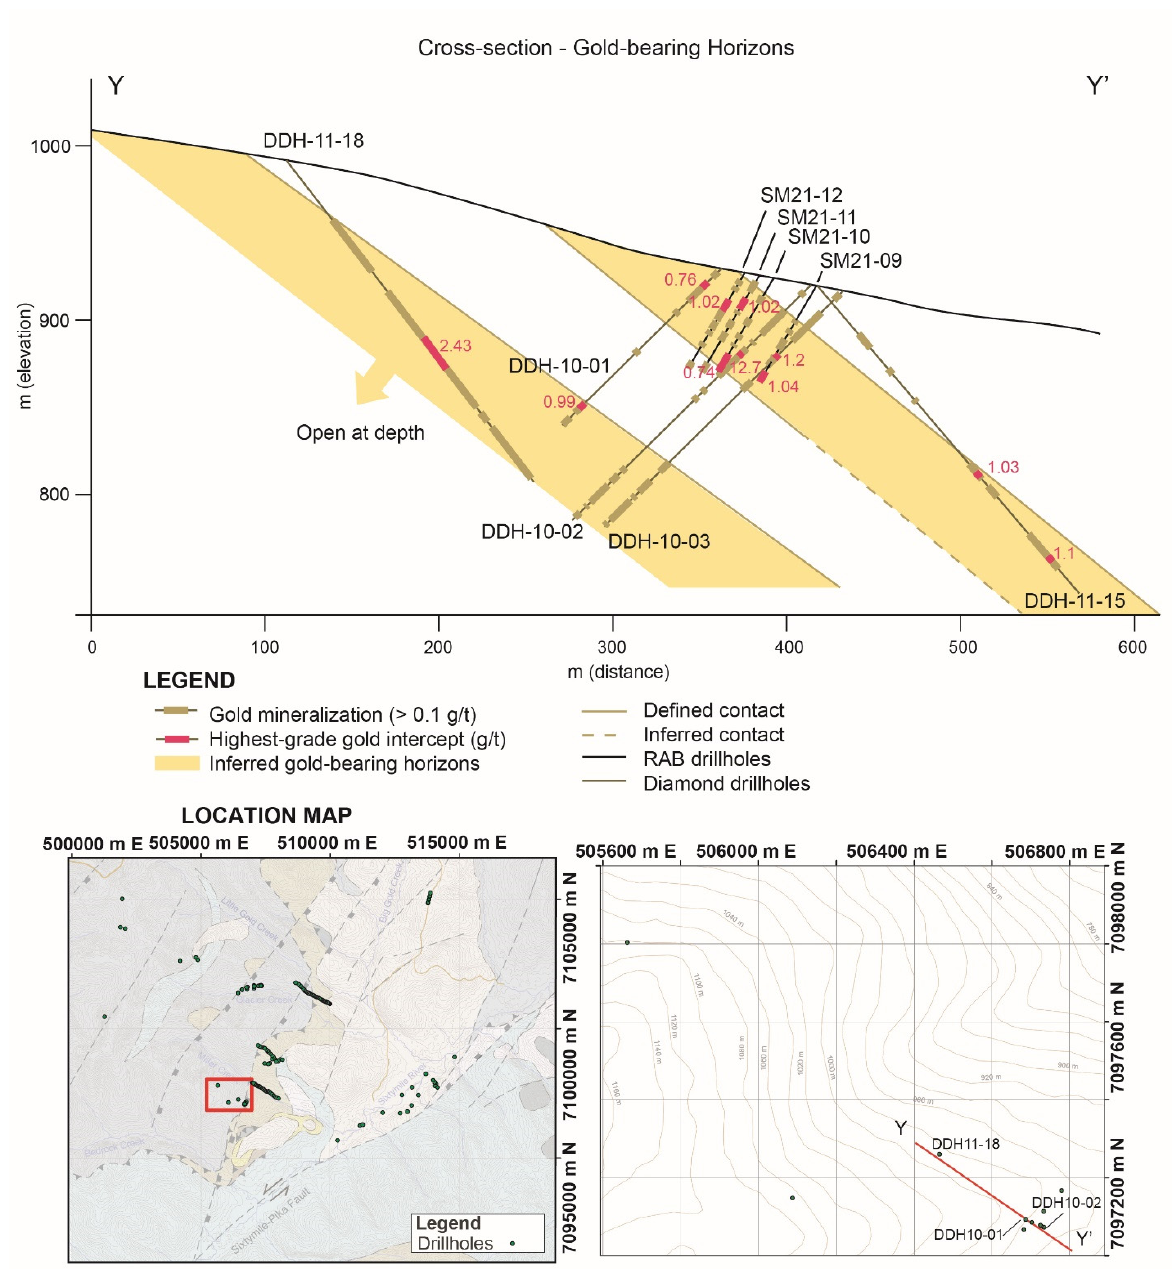
Figure 15. Gold-bearing horizons inferred from drilling. ‘Gold mineralization’ corresponds to gold (Au) assay values above 0.1 g/t Au. A ‘highest-grade gold intercept (g/t)’ is the highest assay value measured within a drillhole interval (~5 m or thicker) that exhibits ‘gold mineralization.’ Coincident magnetic susceptibility values are shown in Figure 16. See Supplementary Table S2, and Figures S1 and S3 for details of drillholes SM21-09 to SM21-12, DDH-10-01 to DDH-10-03, DDH 11-15, and DDH 11-18.